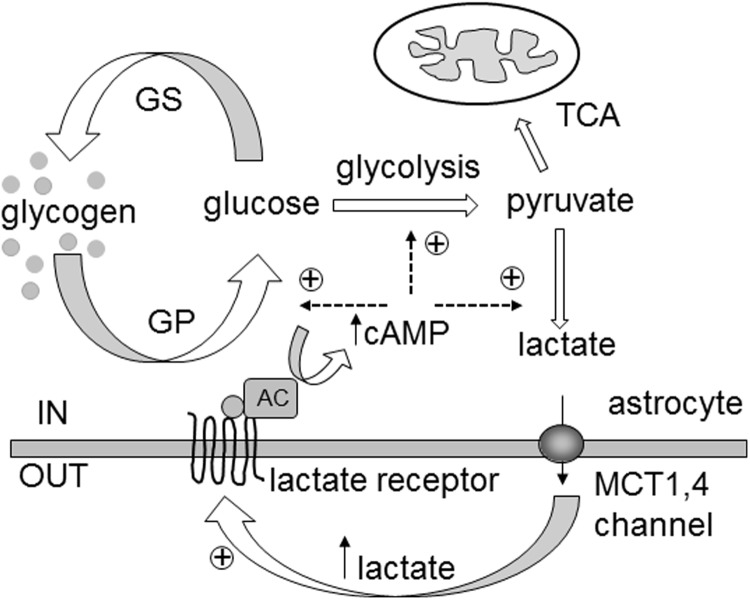
Extracellular L-lactate controls cytosolic lactate synthesis via yet unidentified receptors coupled to adenylate cyclase activity and cytosolic cAMP increase in astrocytes. In the brain, L-lactate is formed in the cytoplasm of astrocytes (IN) and is released through monocarboxylate transporters (MCTs) 1,4 and/or lactate-permeable channels. Extracellularly (OUT), L-lactate can be transported to neighboring cells as a fuel. However, it can also act as a signaling molecule by binding to the L-lactate receptors of neighboring cells, stimulating adenylate cyclase activity (AC) and an increase in cAMP synthesis. Elevated cytosolic cAMP levels facilitate glycogen degradation by activating glycogen phosphorylase (GP) and glycolysis with L-lactate as the end product. In the absence of the L-lactate positive feedback mechanism (“metabolic excitability”), the L-lactate tissue concentration gradient could be dissipated, reducing the availability of L-lactate as a metabolic fuel, when local energy demands, especially in the brain, are high. This model shares similarities with the ‘autocrine lactate loop’ acting (oppositely) on [cAMP]i through GPR81 receptor in adipocytes (Ahmed et al., 2010). GS, glycogen synthase; TCA, tricarboxylic acid cycle. Glucose denotes phosphorylated and free glucose.